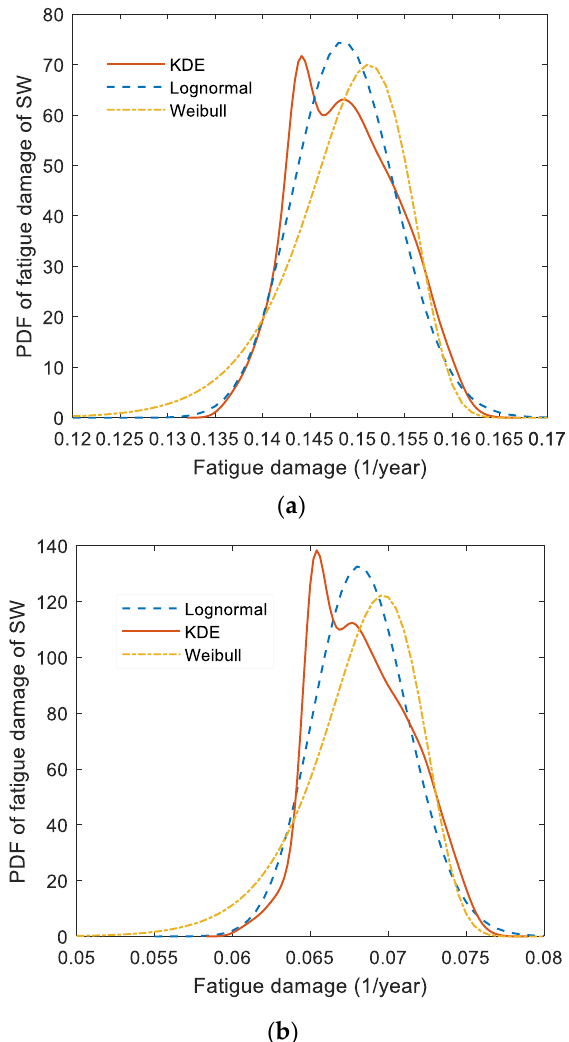
Figure 13. Comparison of parametric and non-parametric estimation results. ( a ) HW. ( b ) LW.